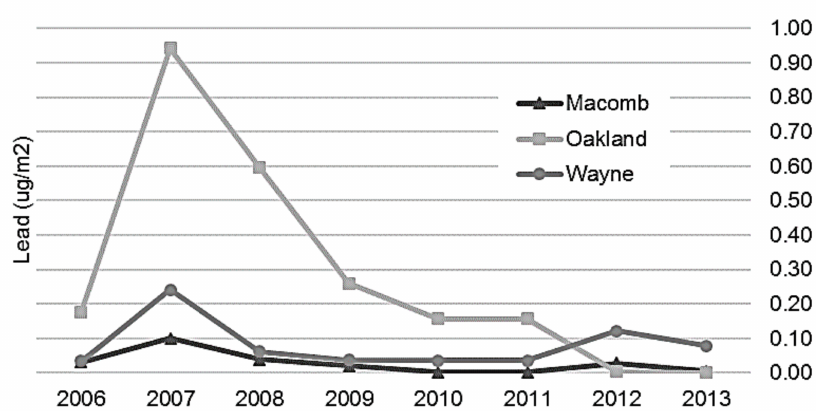
Figure 5. Average depositional lead concentration by county and year, Detroit Metropolitan Area,